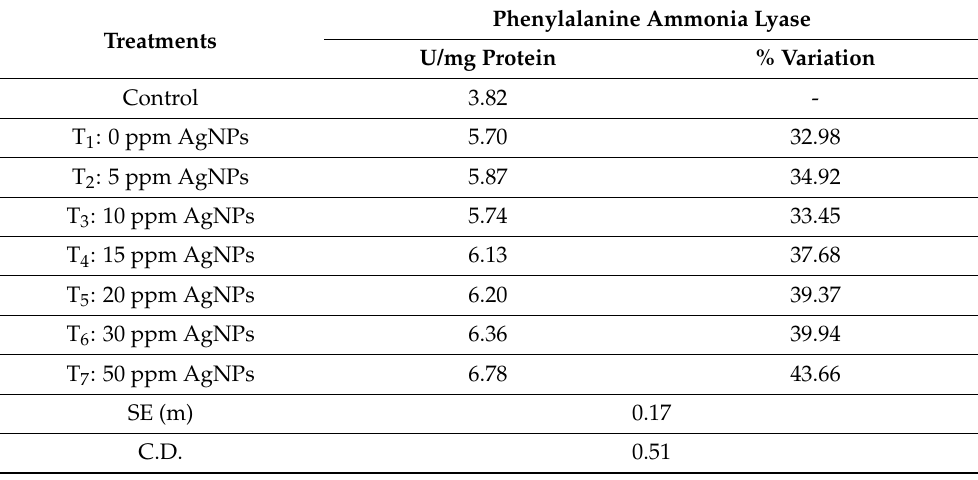
Table 8. Estimation of Phenylalanine ammonia lyase activity in spot blotch infected wheat plant leaves in response to nanoparticle treatment.